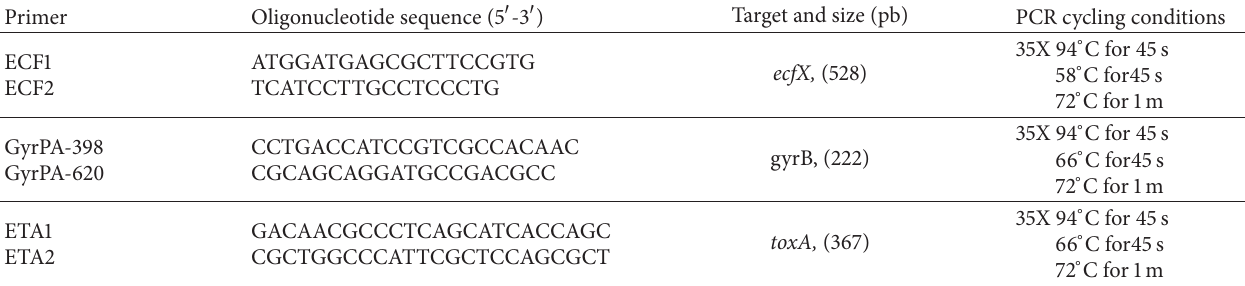
Table 1: Oligonucleotide primers that were used for specific detection of Pseudomonas species. Primer